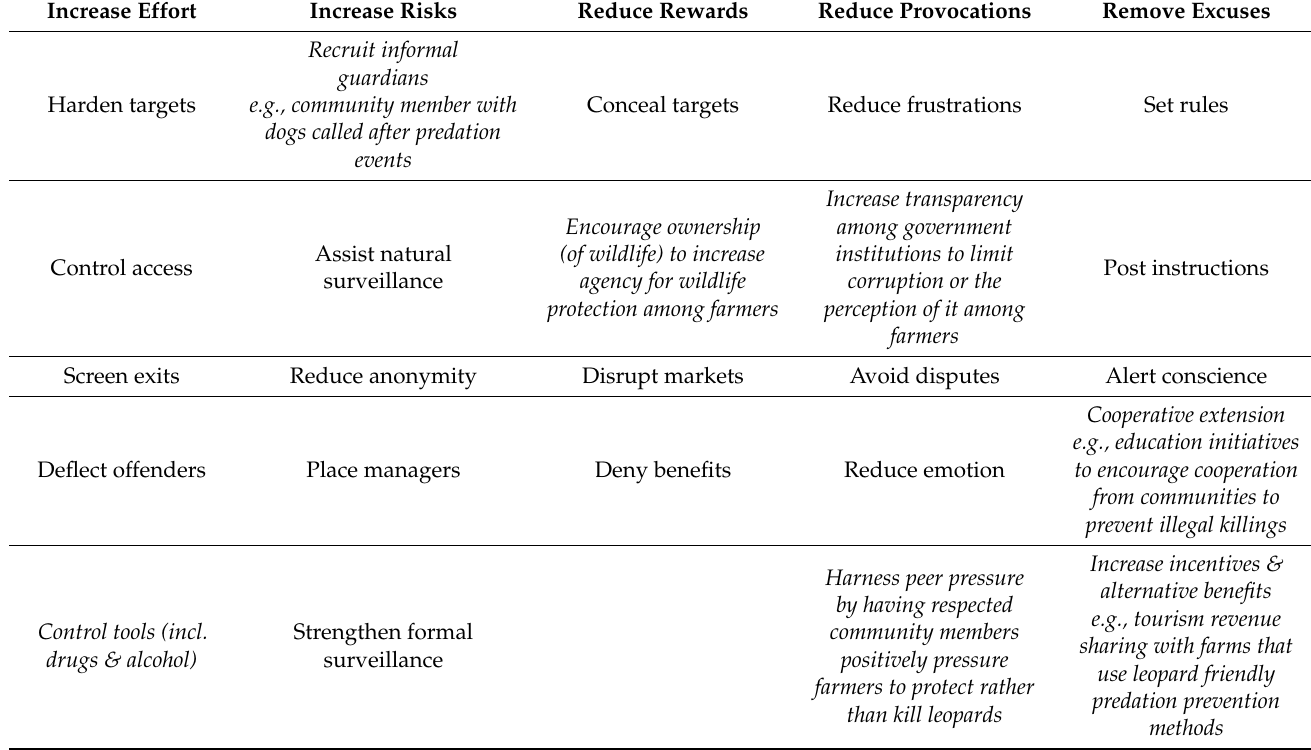
Table A1. Modification of the 25 techniques of situational crime prevention for illegal leopard killings in the South African context * ,1